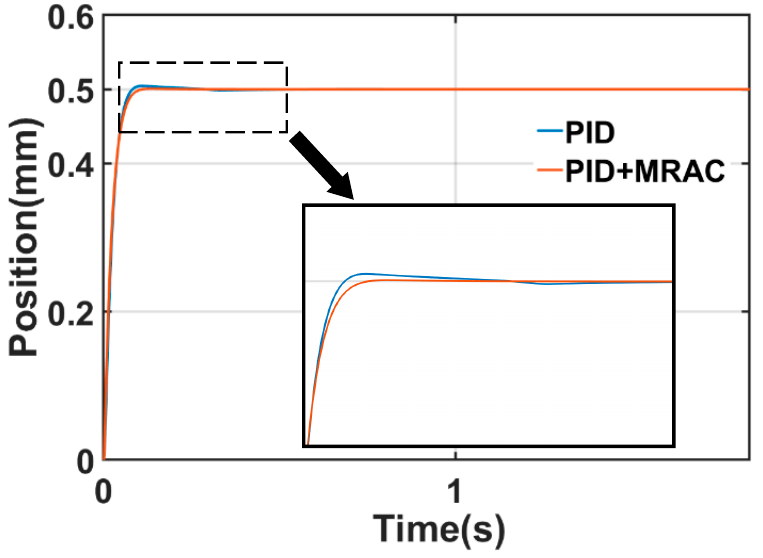
Figure 8. Step response of 0.5 mm.